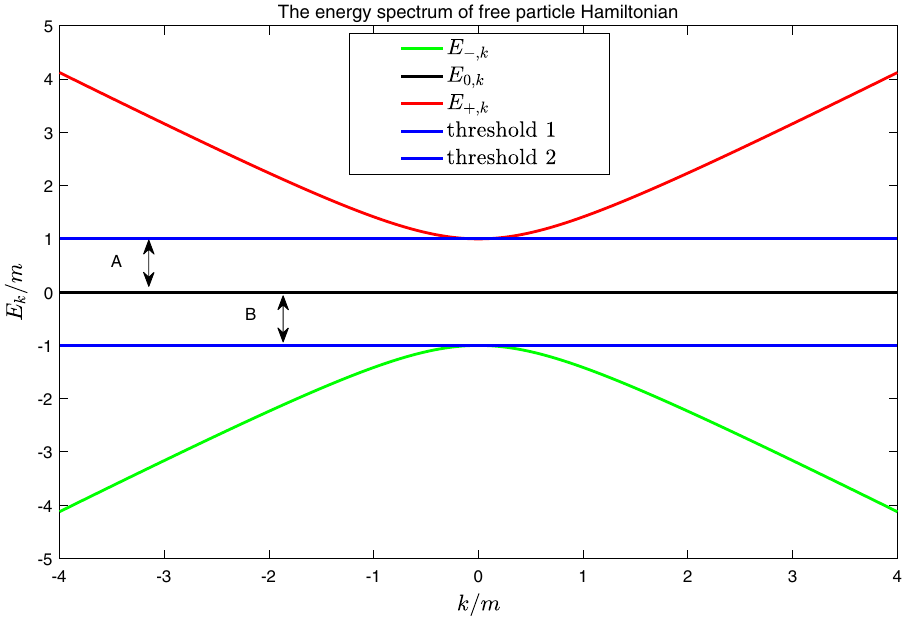
Figure 1. The energy spectrum of free particle Hamiltonian. The possible conventional bound states exist in the gaps ( A ) and ( B ). Any possible bound states in the continuum (BIC) only exist outside these